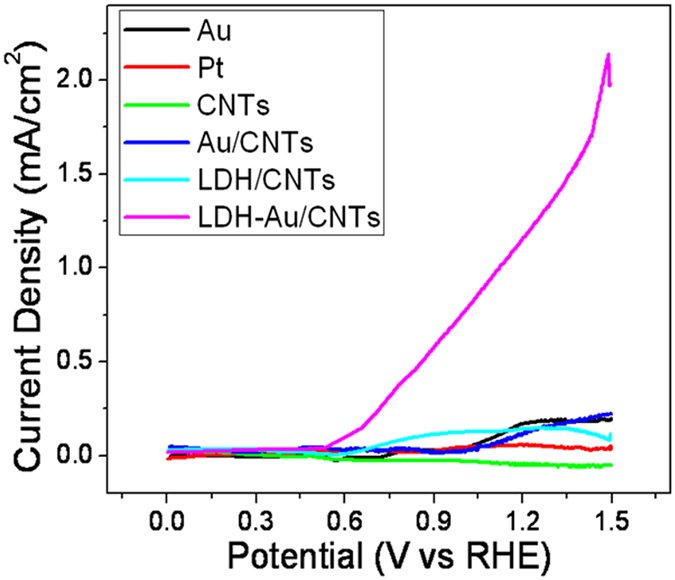
Polarization curves of commercial Au plate and Pt powders, CNTs, LDH-Au/CNTs hybrid and LDH/CNTs catalyst on GC electrode in 0.5 mM KOH in [C4mpy][NTf2].